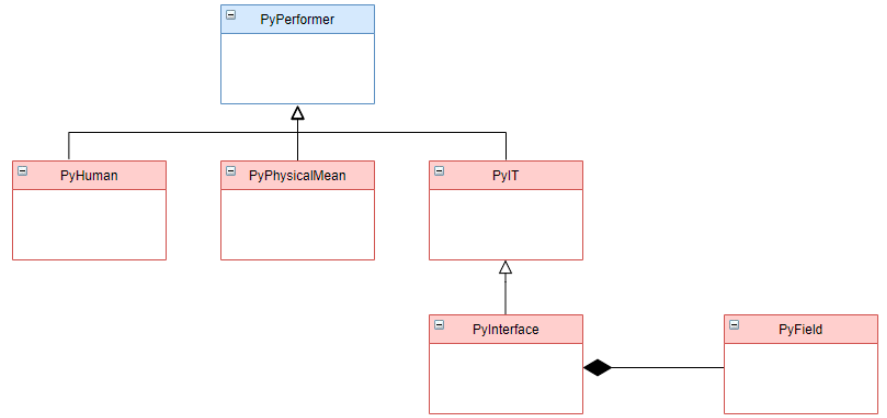
Figure 8. Extension of the PyBPMN metamodel to add composite resources (user and task form).